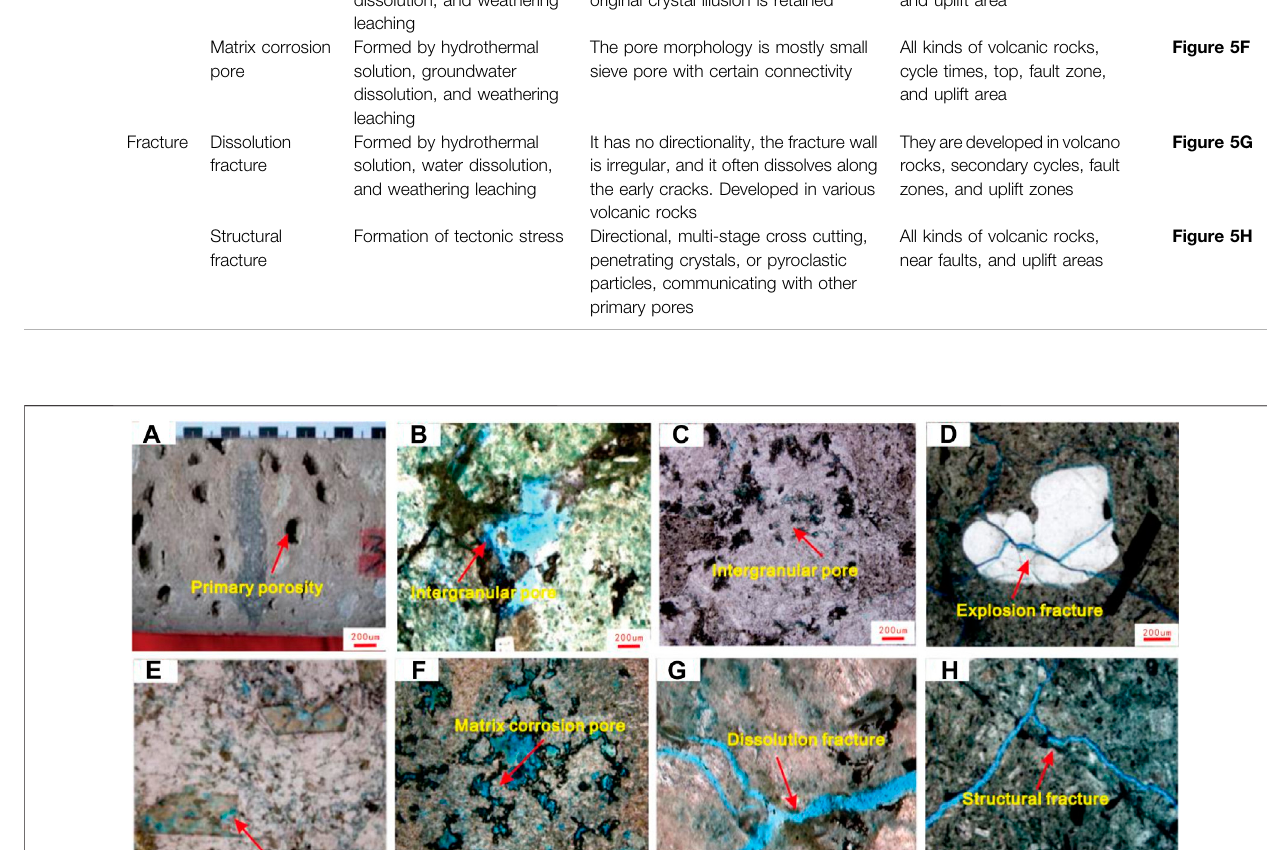
Frontiers in Earth Science |